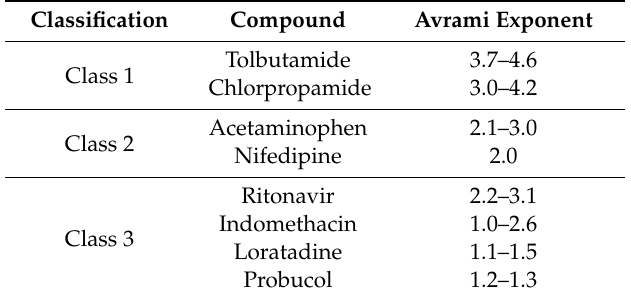
Figure 6. Initiation time of crystallization ( t 10 , min) as a function of T g / T . The q and FD labels in the parentheses indicate that the glass was prepared by quenching and freeze-drying, respectively. The numbers in parentheses denote the crystallization tendency classification. The universal line is the best fit for Classes 1 and 2 compounds (ln( t 10 ) = 66.2 T g / T − 57.0). Table 5. Ranges of Avrami exponents for isothermal crystallization.